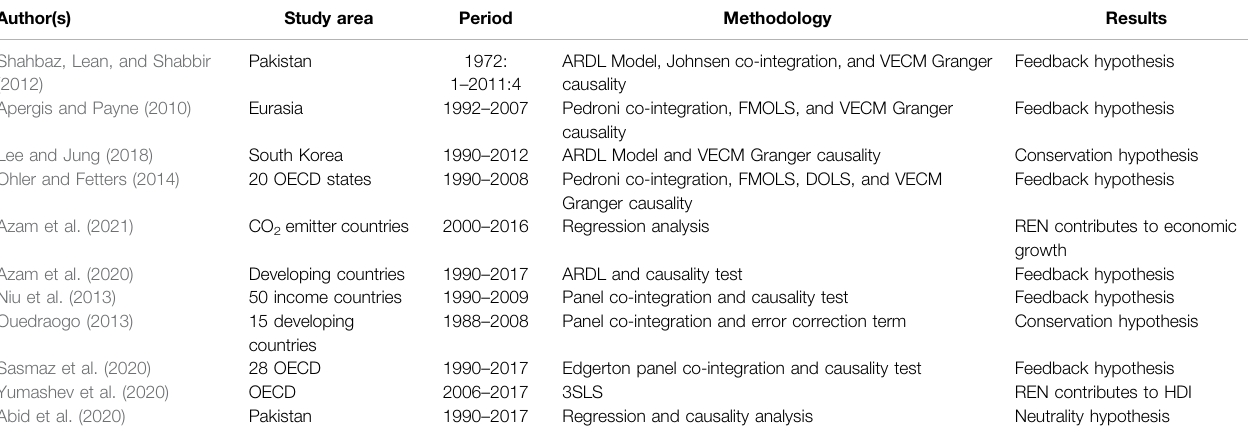
TABLE 1 | Summary of the literature renewable energy consumption – economic growth and human development index